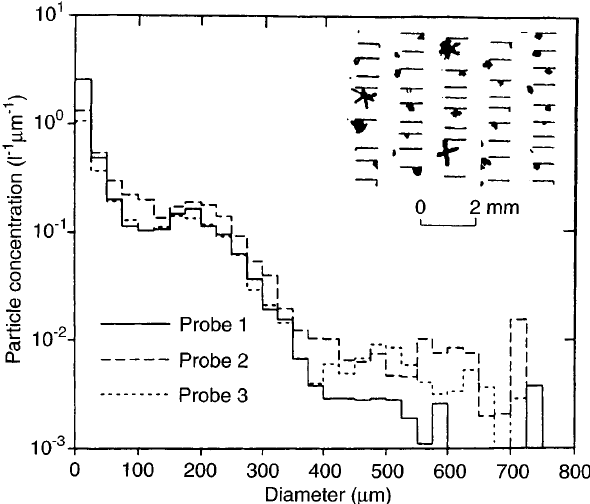
Fig. 1. Particle-size spectra obtained from simultaneous measure- ments by three di(cid:128)erent PMS 2D-C probes for a 2-mn segment in a cirrostratus cloud. An example of corresponding sample ice-crystal habits is shown in the upper-right of the